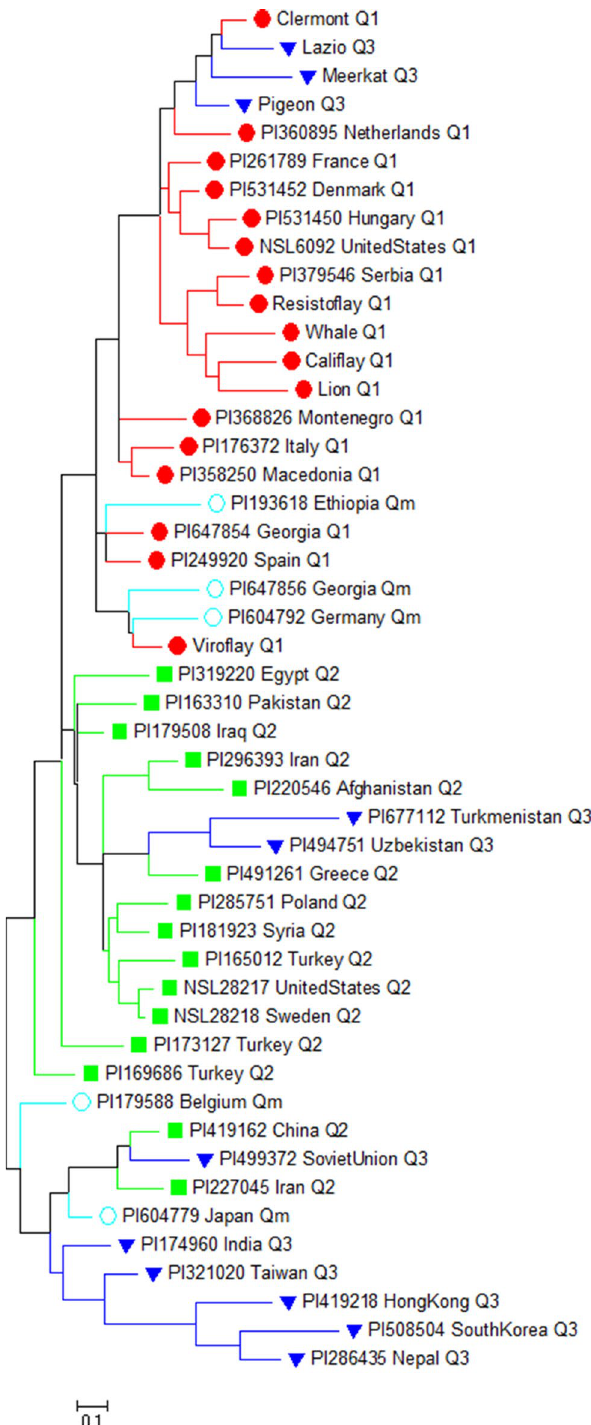
Figure 7. The maximum likelihood Neighbor-joining tree of 48 spinach accessions drawn in MEGA. The accessions color codes are consistent with the PCA and STRU CTU